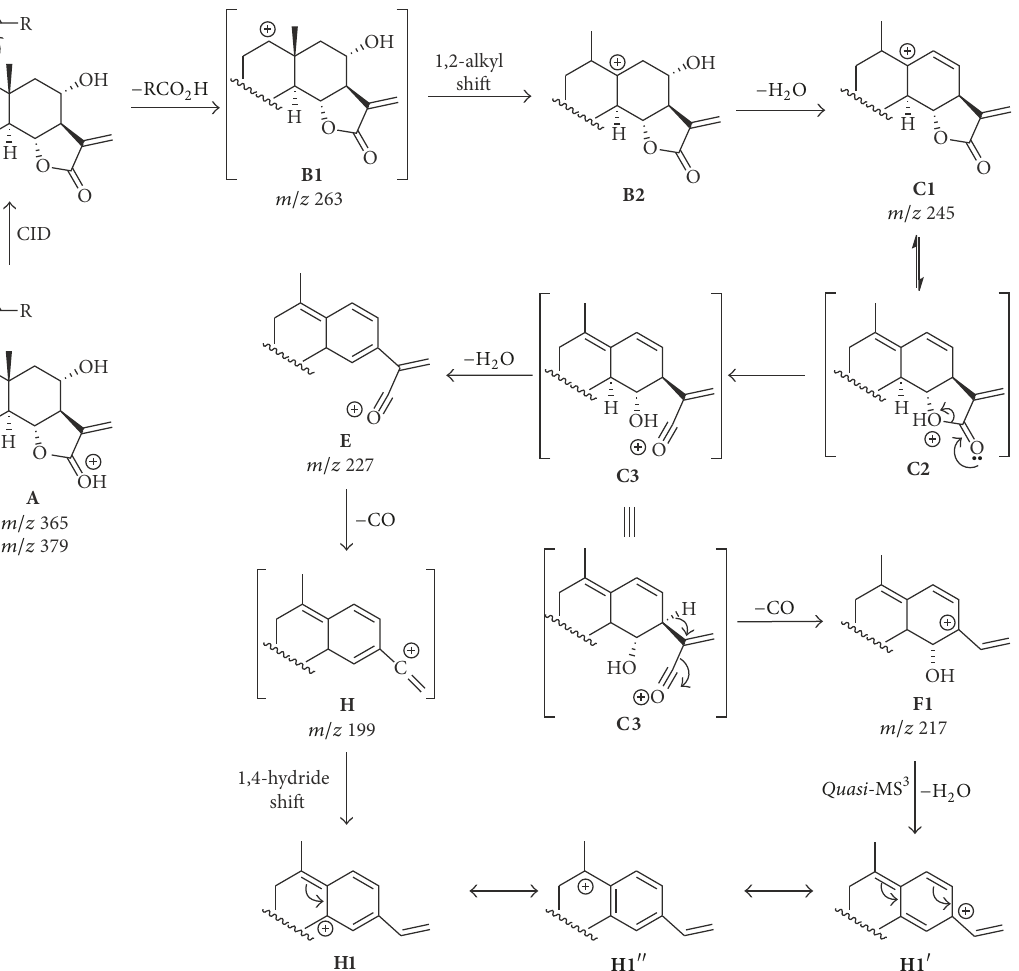
Scheme 2: Formation of the general product ions B , C , E , F, and H of protonated 1 and 2